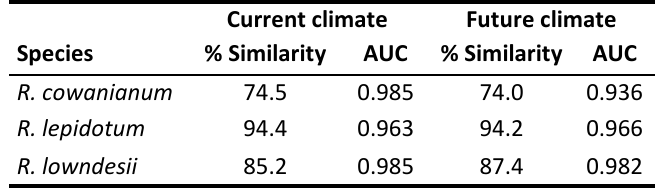
Table 3. Similarity in the potential area of distribution (in per- centage) between models with all variables (set I) and those with GLM - selected variables (set II) under current and future climate conditions and their respective model AUC